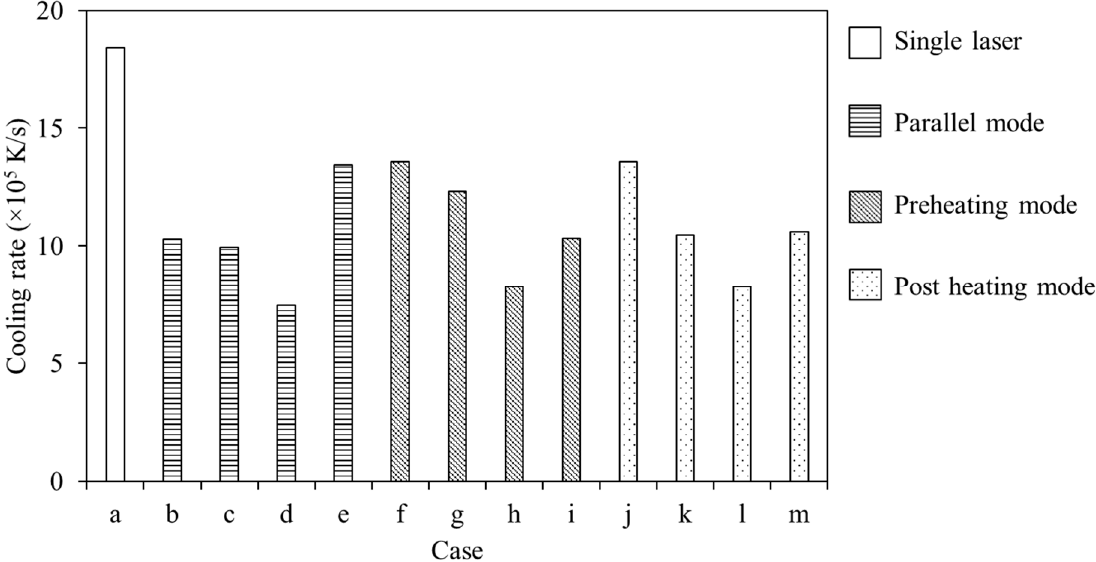
Figure 8. Cooling rate at the P1 position of model (Figure 1) by different scanning modes and process parameters: ( a ) single laser beam; ( b )–( e ) parallel model; ( f )–( i ) preheating mode; and ( j )–( m ) post ‐ heating mode.